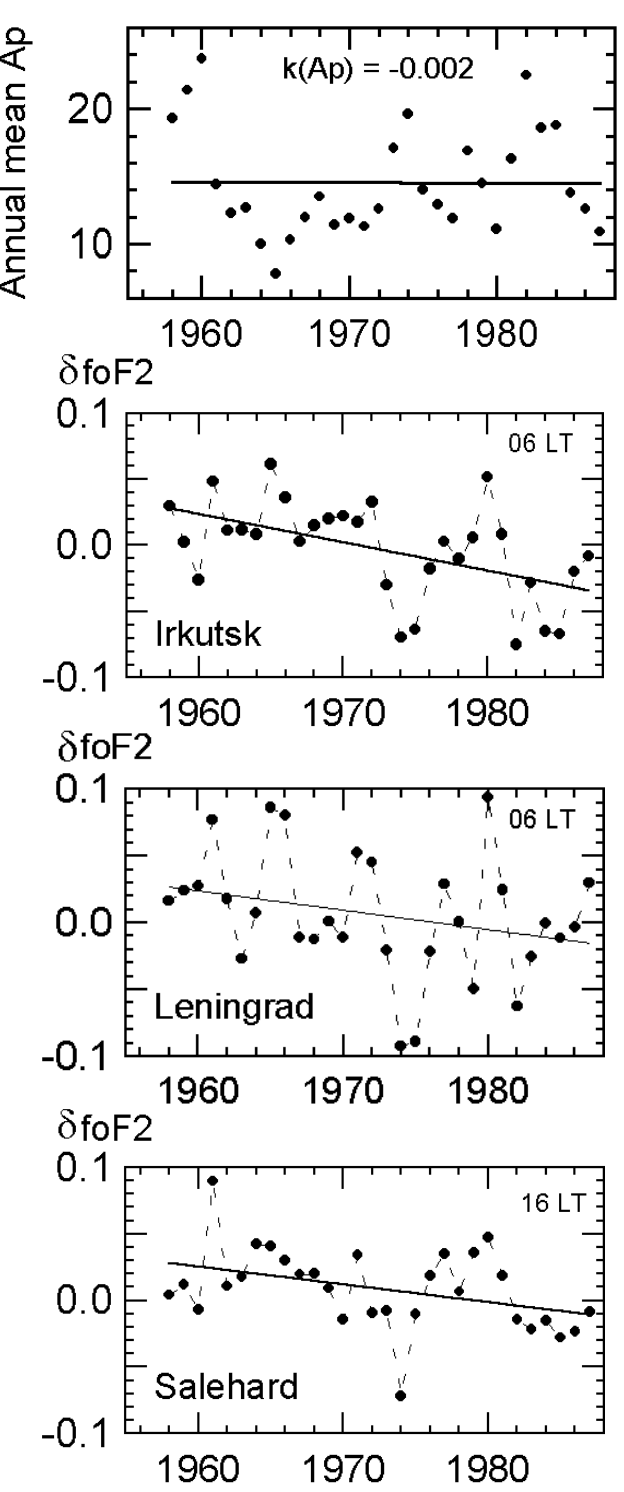
Fig. 5. Variations of A p (top panel) and δ f o F2 for three stations for the 1958–1987 period. (the values of k( obs ) for Irkutsk, Leningrad, and Salekhard are -0.0011, -0.0014, and -0.0013 per year, respec-